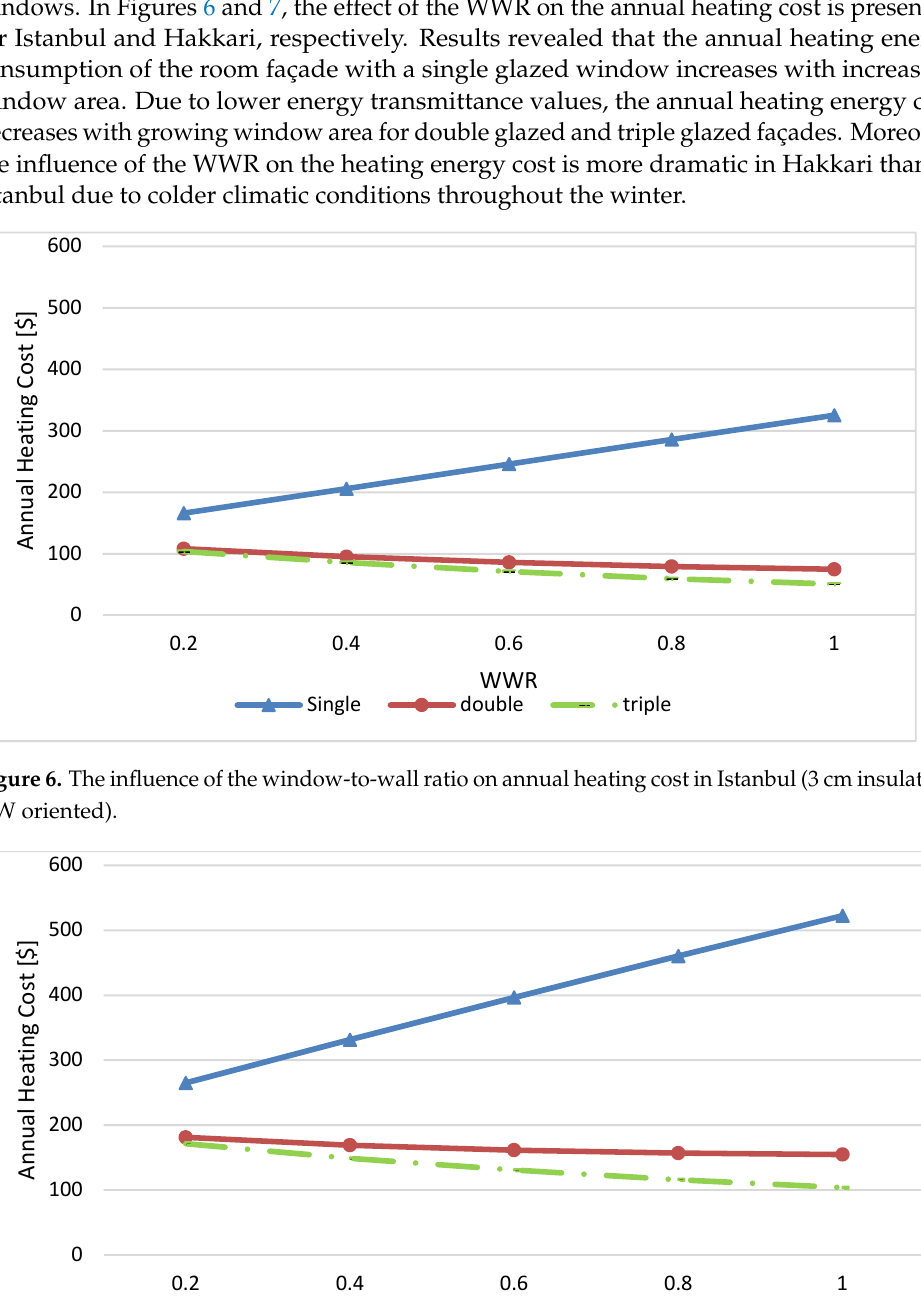
Figure 5. The influence of orientation on the net present cost of the building façade in Istanbul .